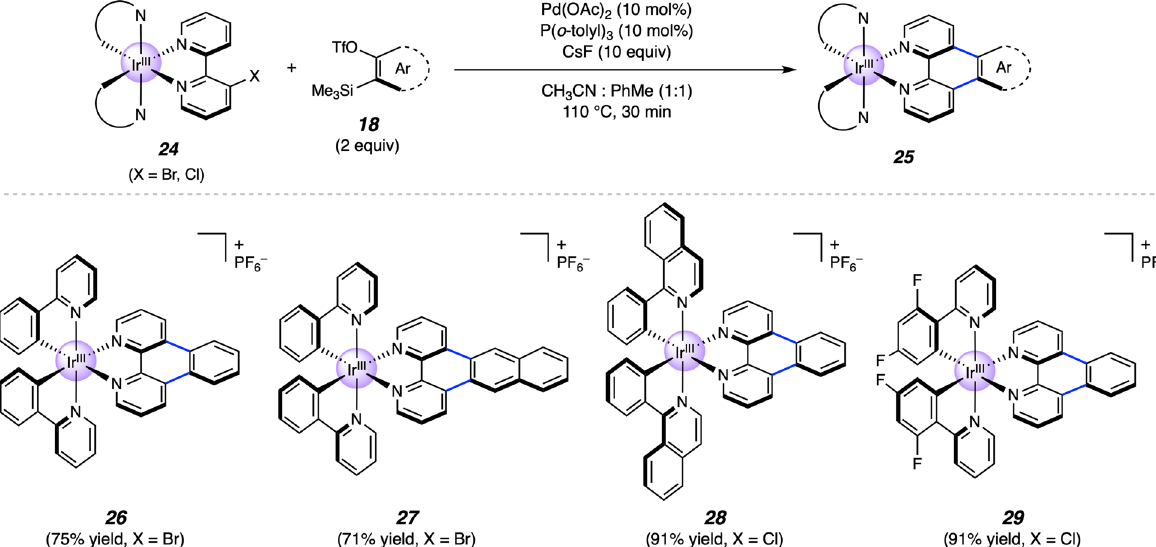
Fig. 5 Pd-catalyzed aryne annulation of Ir-centered polypyridyl metal complexes. Yields shown re fl ect the average of two isolation experiments. OTf, tri fl